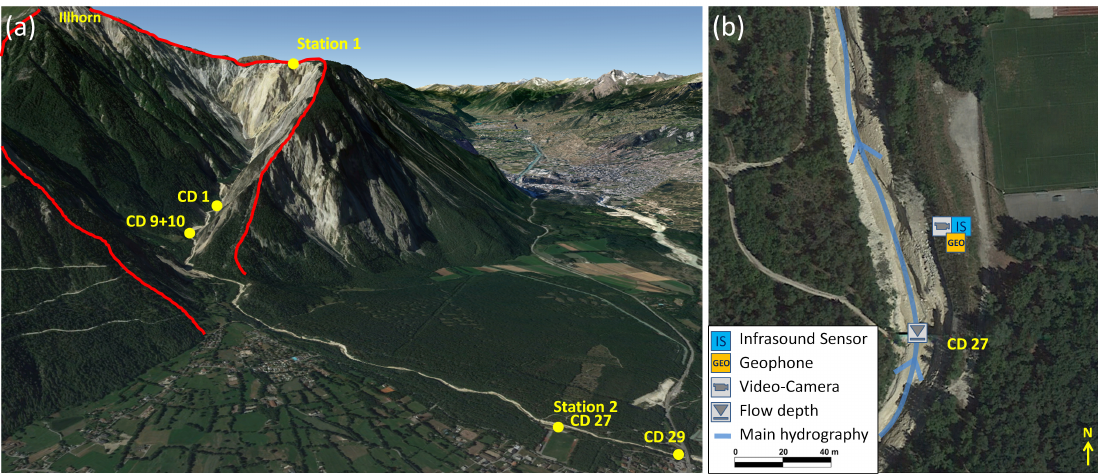
Figure 6. ( a ) overview of the test site Illgraben (red line: catchment area); ( b ) closer view of the monitoring station 2 and sensor setup (Source: Google